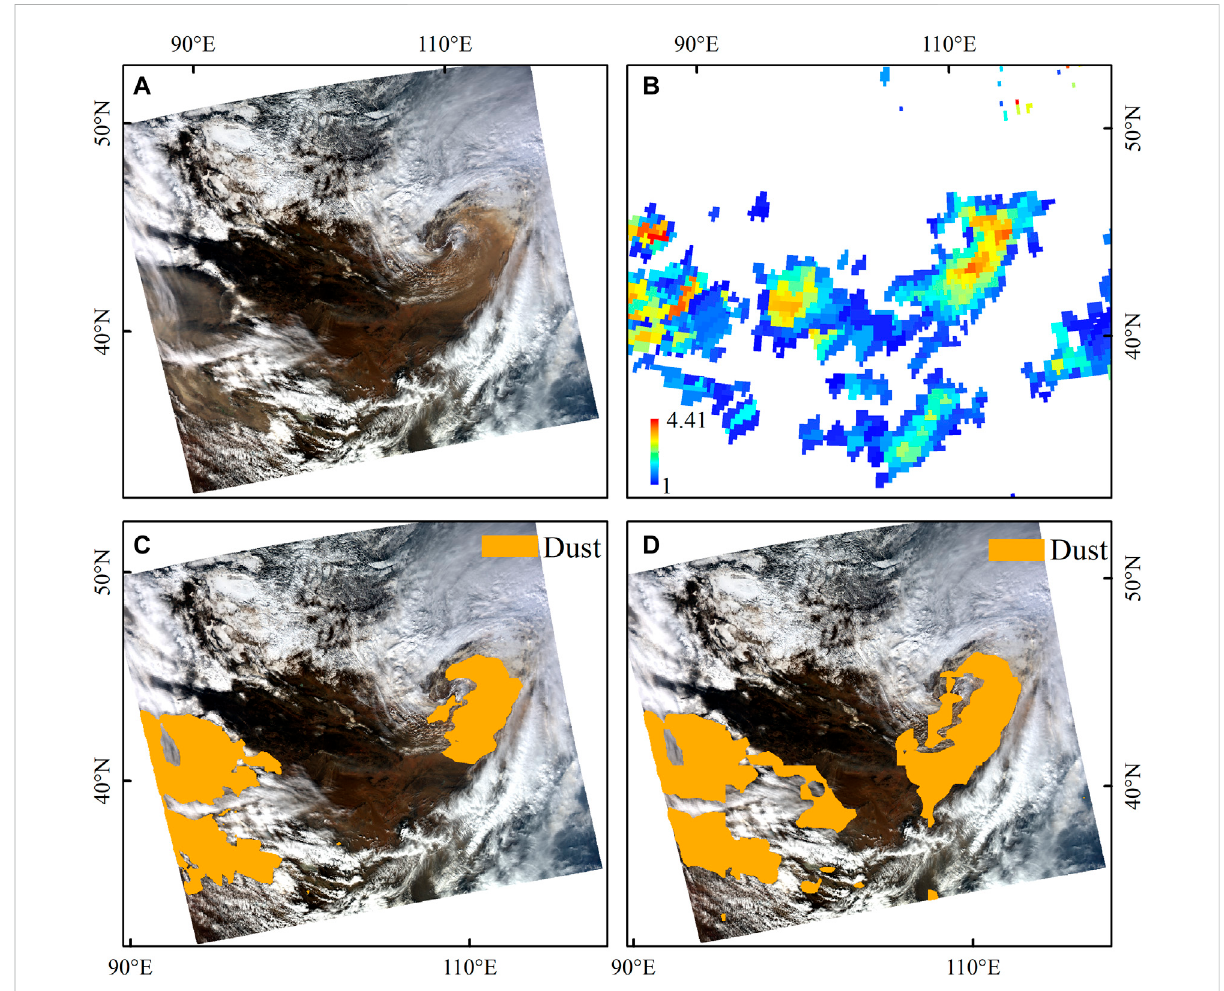
FIGURE 9 Comparison of sandstorm detection results in cloud/bare land the region on 3 March 2016. Spatial distributions of MODIS image (band:1-4-3) (A) , OMI AI product (B) , detection results of space sandstorms with LSR (C) , and detection results of space sandstorms in MODIS images without LSR (D)